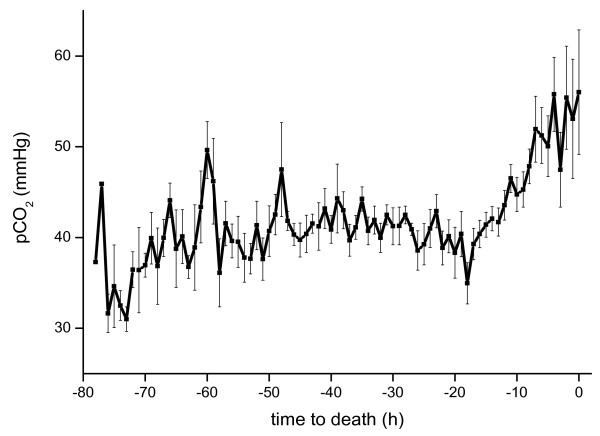
Escalating pCO2 (mmHg) in relation to hours to death.